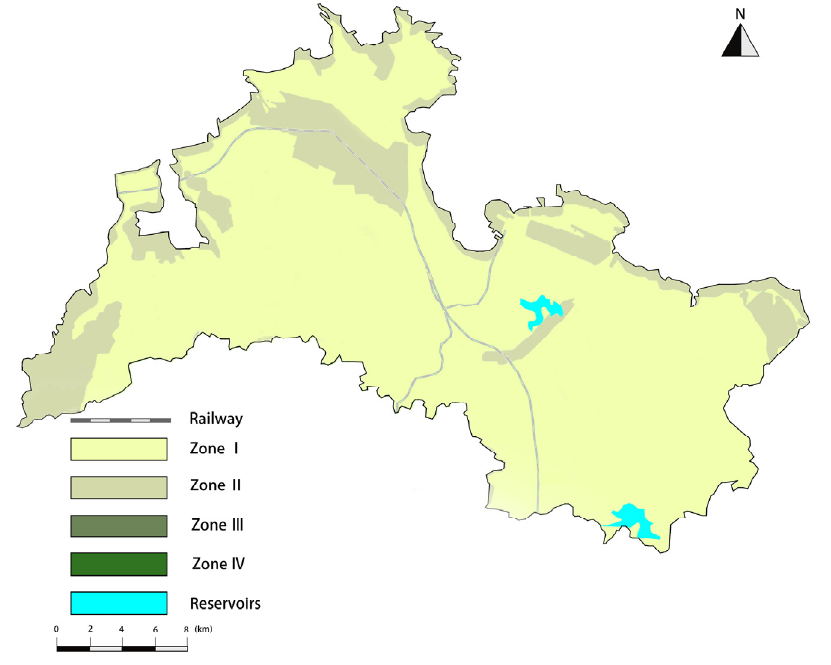
Figure 5. Comprehensive evaluation diagram of underground space resource development suita ‐ bility (30~100 m).